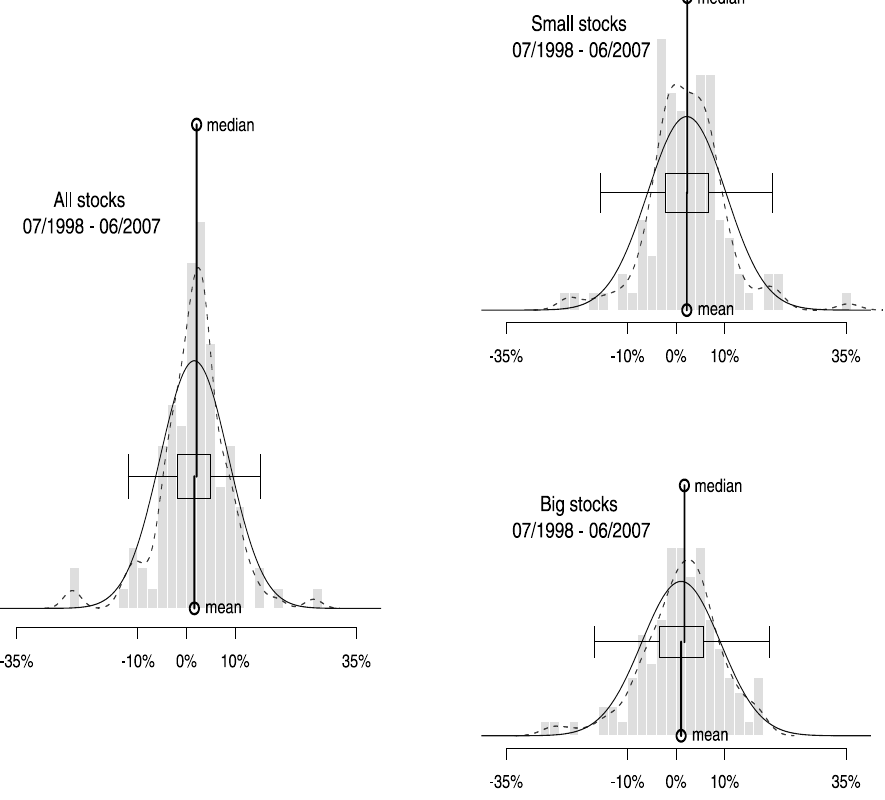
FIGURE 1: Distribution of the Value Premium among all firms and among small and big firms Source: